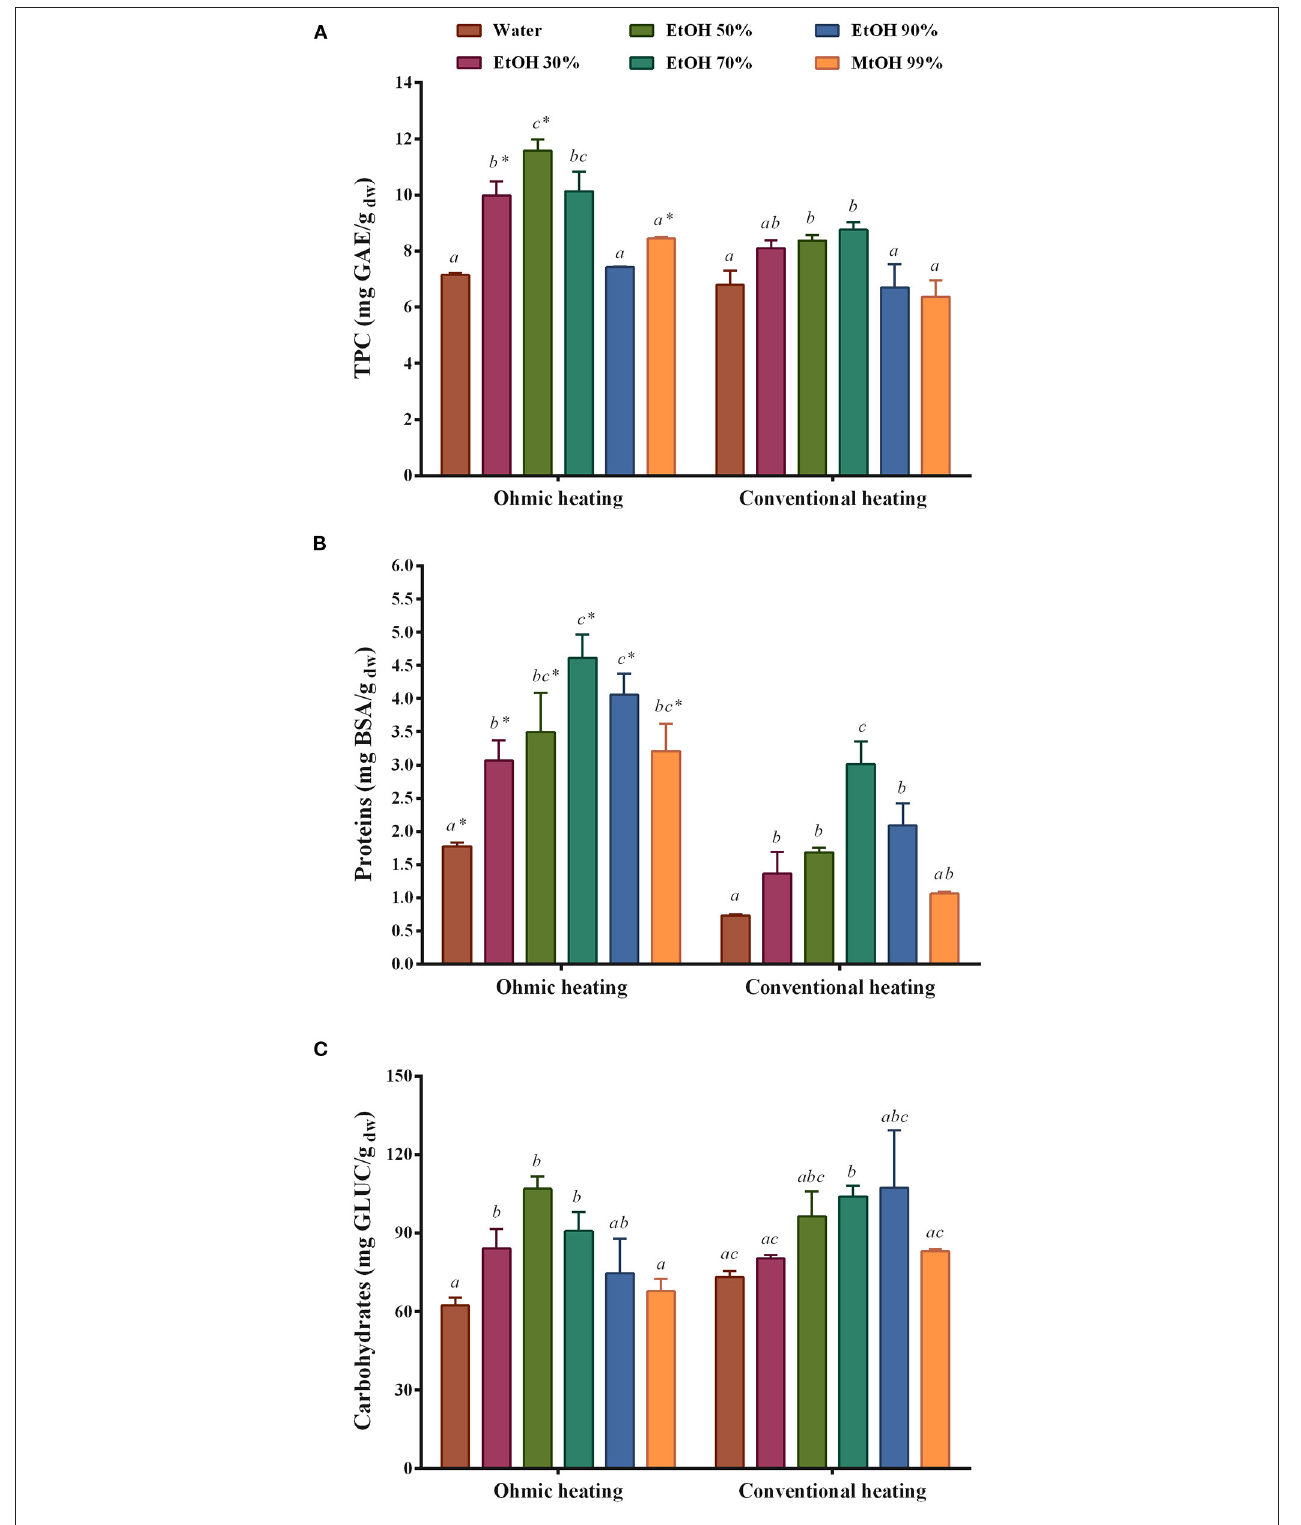
FIGURE 2 | Total phenolic (TPC) (A) , protein (B) , and carbohydrate (C) extraction yields of Red eggplant extracts. Influence of solvents using conventional heating and OH-assisted extraction methods. Values are expressed as mean ± SD. Different letters show significant differences ( p < 0.05) between extraction solvents for the same extraction technologies. *Show significant differences ( p < 0.05) between extraction technologies for the same solvent.